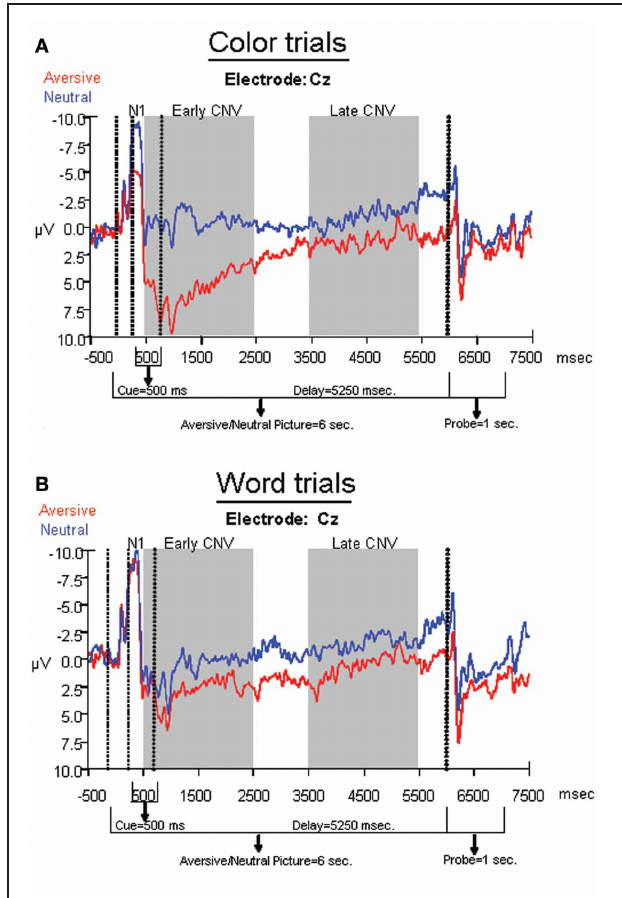
FIGURE 4 | Average ERPs for aversive and neutral conditions within (A) color trials and (B) word trials. Electrode Cz was chosen for display purposes, as it was analyzed across the N1, early, and late CNV